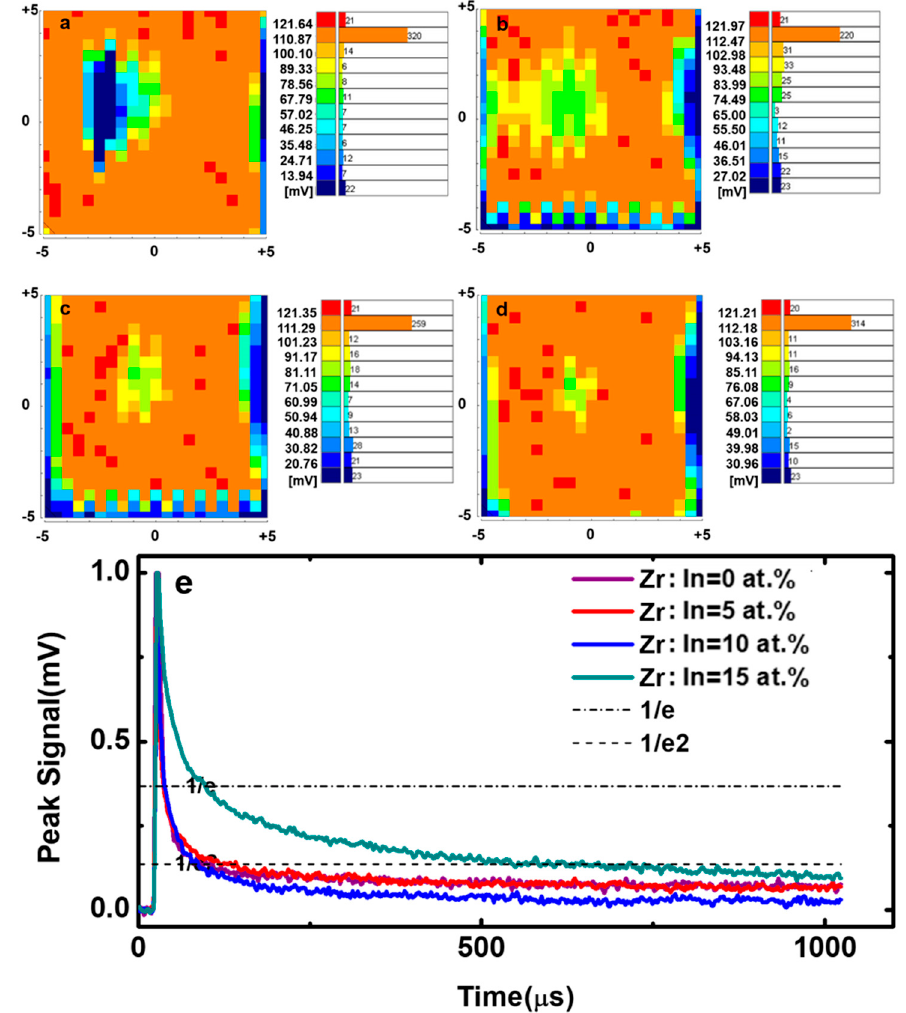
Figure 7. The result of microwave photoconductivity decay ( µ -PCD) mapping scan of In 2 O 3 thin films when the Zr doping ratio was ( a ) 0 at.%, ( b ) 5 at.%, ( c ) 10 at.%, and ( d ) 15 at.%. ( e ) µ -PCD decay curves.